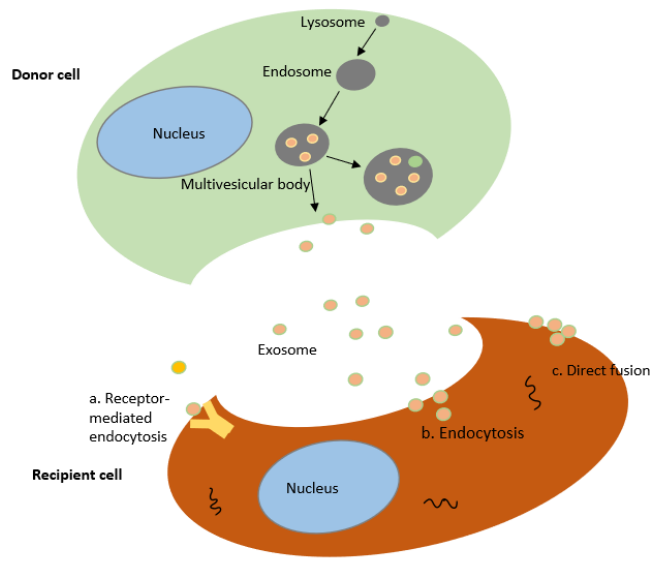
Figure 1. The biogenesis of exosomes. Exosomes are secreted by donor cells into the intercellular microenvironment via multivesicular bodies. Exosomes can transfer biologically functional molecules to recipient cells in three ways (a) intercellular signaling through receptor-ligand binding, (b) endocytosis of recipient cells, (c) direct fusion of exosomes with the recipient cells membrane, after which exosomes release their contents.